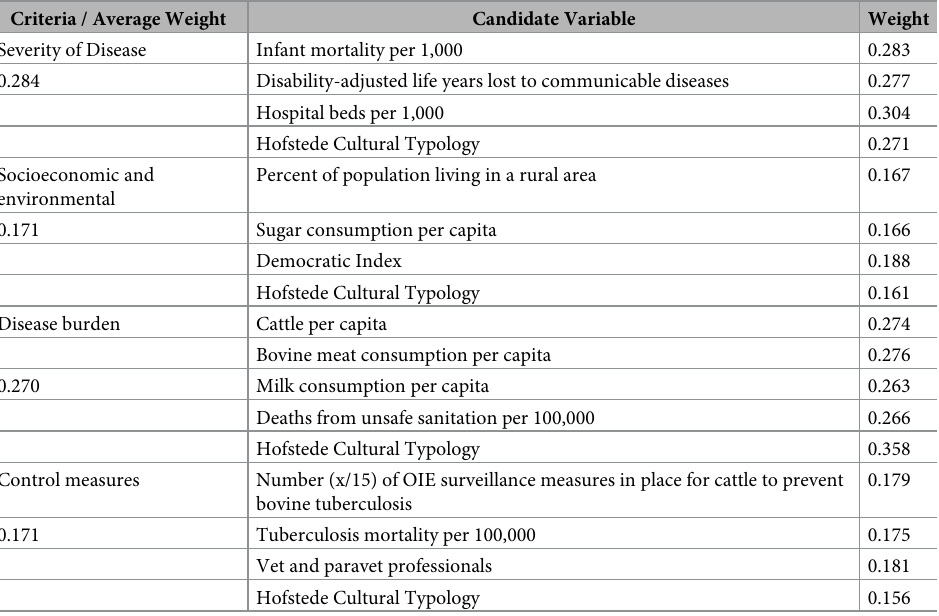
Table 4. Estimated weights for modified tool calculated from candidate variables.